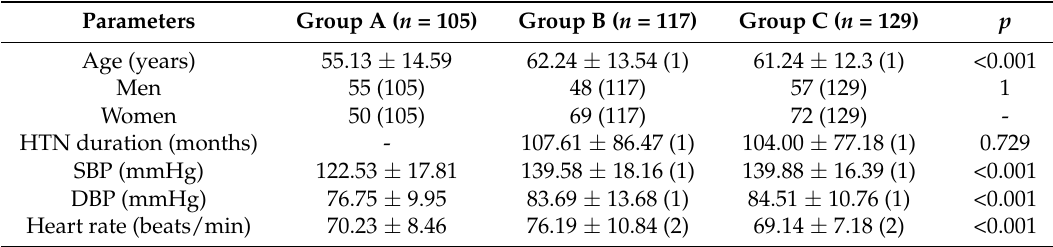
Table 1. Characteristics of the control and study groups.